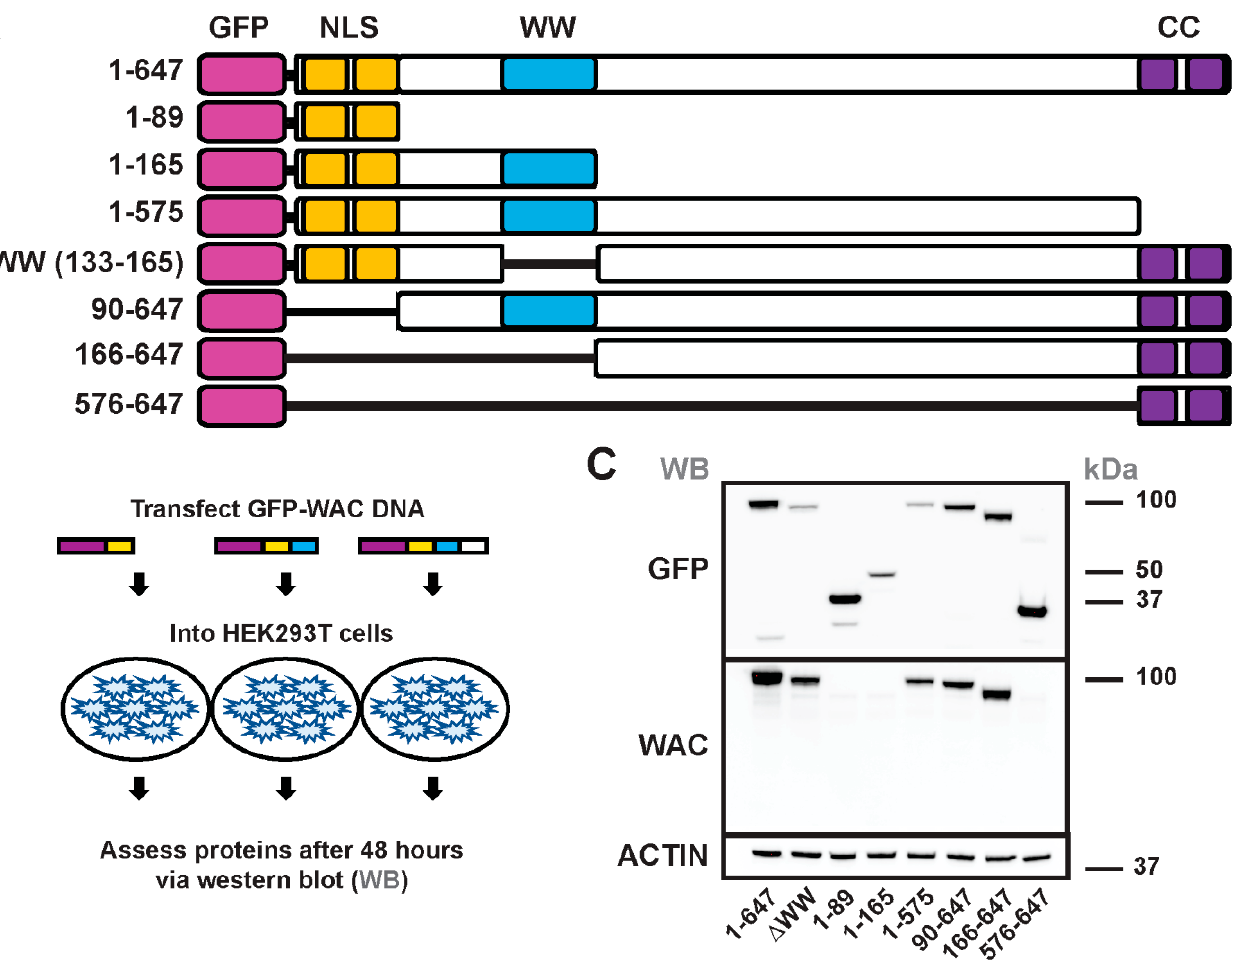
Figure 5. Assessment of GFP-WAC deletion mutant proteins. Schema showing the various GFP- WAC vectors generated to assess conserved protein domains ( A ). ( B ) GFP-WAC vectors were trans- fected into HEK293T cells to express proteins. ( C ) Western blots demonstrating expression of the various GFP-WAC proteins after 48 h. Top panel probed with an anti-GFP antibody and bottom panel probed with a commercial anti-WAC antibody. (kDa) kilodaltons.